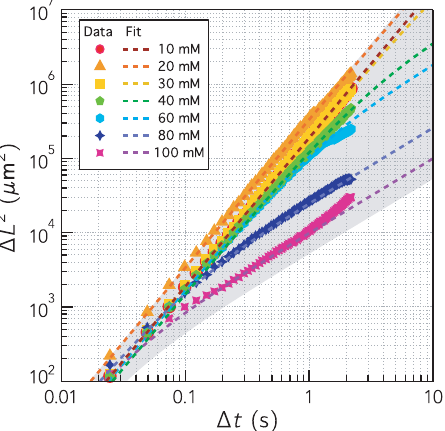
FIG. 6. Mean square displacement curves, averaged over tens of trajectories, show a decrease in the crossover time τ as a function of SDS concentration. The model of rotational diffusion in Eq. (3) gives an excellent fit to the data and the gray area corresponds to the 95% confidence